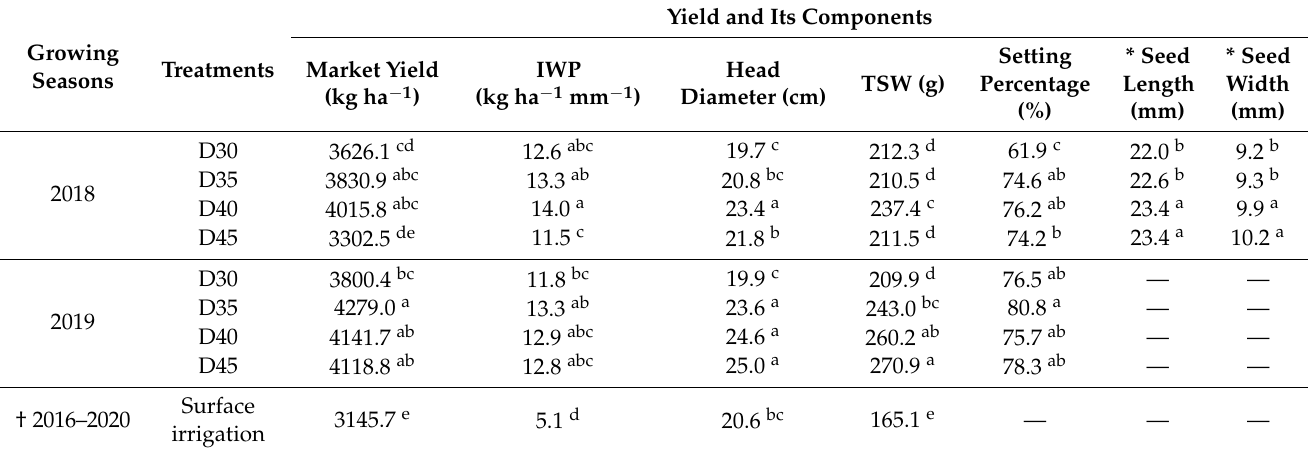
Table 6. Sunflower yield and its components in different treatments in the two growing seasons. IWP and TSW are abbreviations for irrigation water productivity and thousand seed weight,